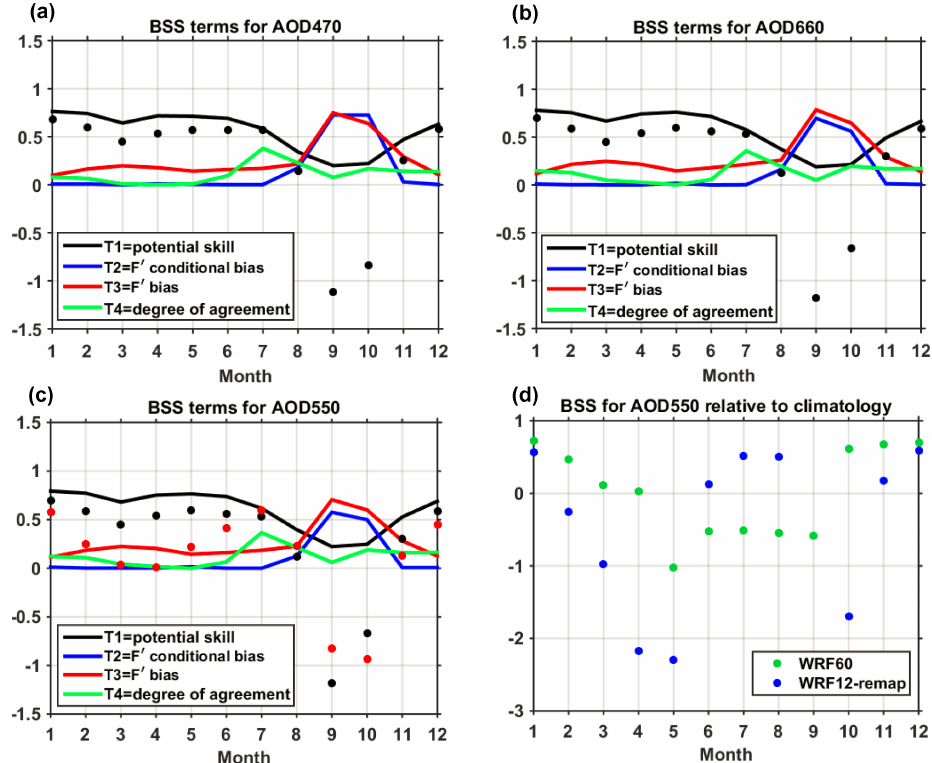
Figure 5. (a–c) Brier skill scores (BSS, black dots) for monthly mean AOD by calendar month (1 = January) for AOD at 470, 550 and 660nm. In this analysis of model skill WRF12 output is mapped to the WRF60 grid (WRF12-remap) and BSS are computed using MODIS as the target, WRF60 (driven by NAM12 meteorological boundary conditions) as the reference forecast and WRF12-remap as the forecast. Also shown by the color lines are the contributions of different terms to BSS. In panel (c) the red dots indicate BSS when the reference forecast is WRF60 driven by GFS meteorological boundary conditions. (d) BSS of monthly mean AOD from WRF60 (green dots) and WRF12-remap (blue dots) relative to MODIS monthly mean climatology during 2000–2014 (reference forecast). Monthly mean AOD from MODIS are used as the target. BSS for WRF12-remap in September is − 6.1.